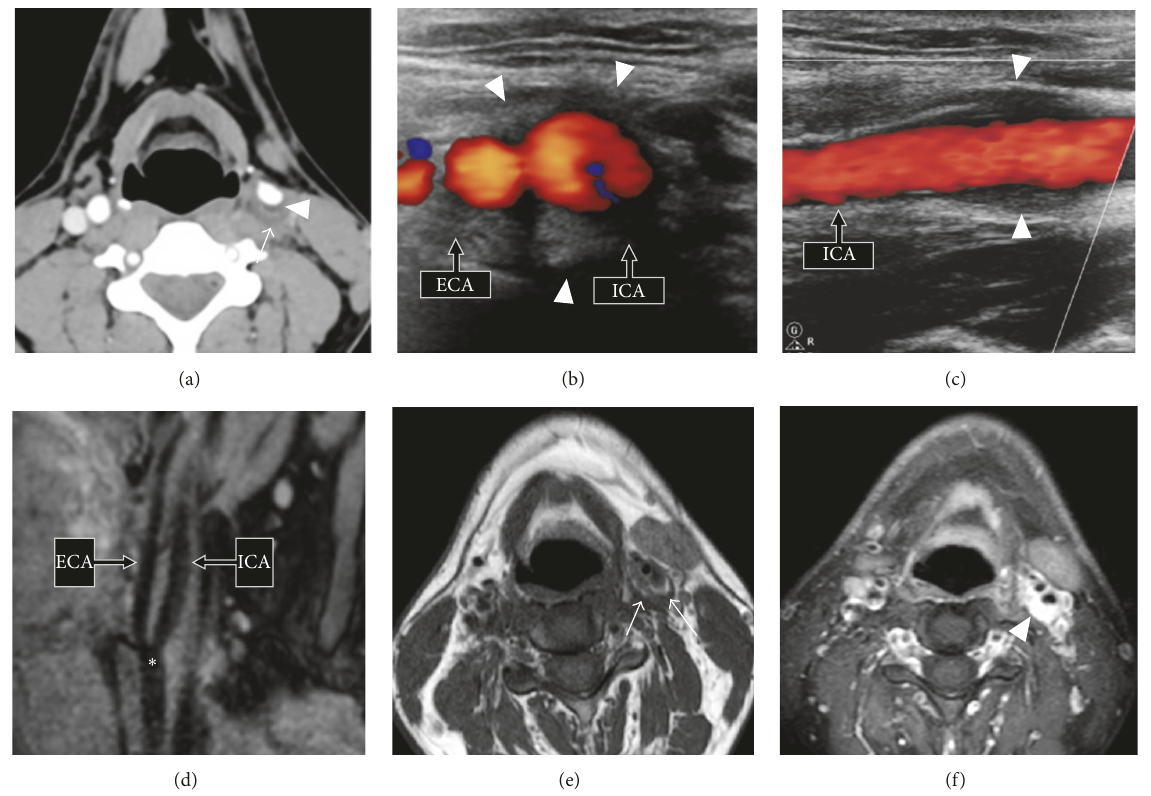
Figure 1: (a) Axial contrast-enhanced CT scan (soft tissue window) shows poorly delineated thickening of the left carotid bulb wall (arrow) . Note obliteration of the pericarotid fatty tissue. Minimal vessel narrowing ( < 20%) due to fibrolipid plaque (arrowhead) . (b, c) Axial and longitudinal views of Doppler US examination show fusiform eccentric wall thickening of the left proximal internal carotid artery (ICA) and external carotid artery (ECA) isoechoic to muscle (arrowheads) . (d) Sagittal multiplanar reformatted (MPR) image from a 3D volume turbo spin echo acquisition centered on the left carotid bulb (asterisk) shows no evidence of spontaneously T1 hyperintense parietal hematoma, thus ruling out carotid artery dissection. No aneurysm is seen. (e) Axial T1-weighted MR image reveals a hypointense circumferential lesion involving the left carotid bulb and pericarotid fatty tissue (arrows) . (f) Intense enhancement (arrowhead) of the mass-like soft tissue lesion on the axial postcontrast fat-saturated T1-weighted MR image. Note that perivascular enhancement and vessel wall enhancement can be hardly differentiated from one another. ICA: internal carotid artery and ECA: external carotid